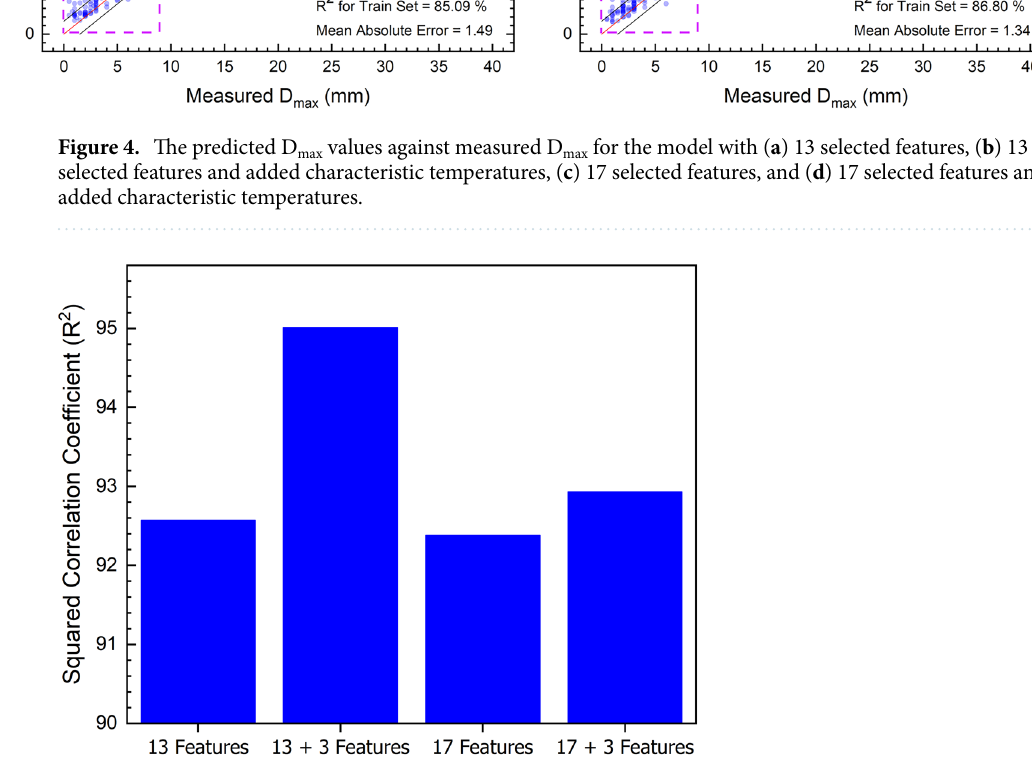
Figure 5. The squared correlation coefficient for models with 13 features with and without characteristic temperatures and 17 features with and without characteristic